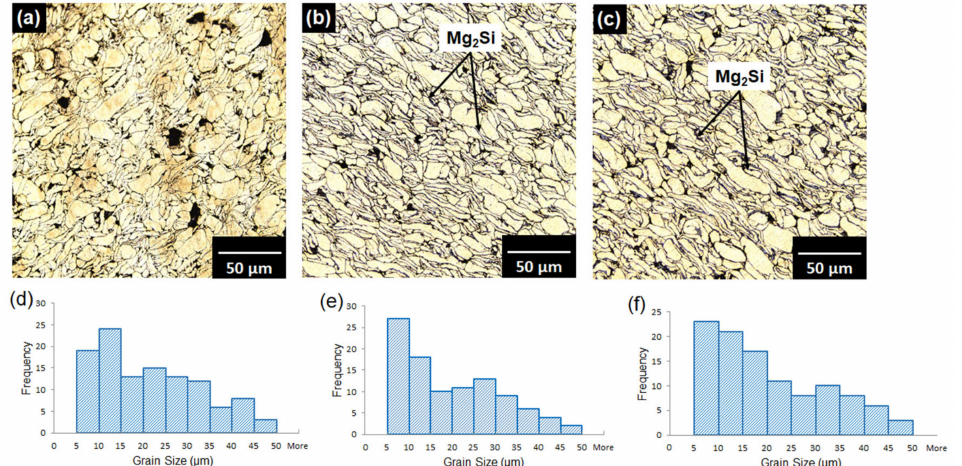
Figure 3. Optical micrograph and grain size histogram of ( a , d ) Mg alloy AZ31, ( b , e ) Mg + 3% SiO 2 , ( c , f ) Mg + 5% SiO 2